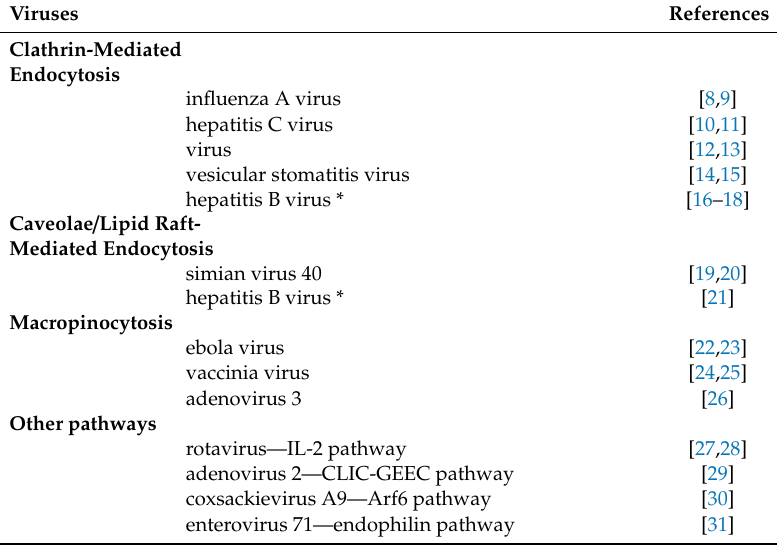
Table 1. Examples of viruses and the endocytosis pathways they use to enter cells.